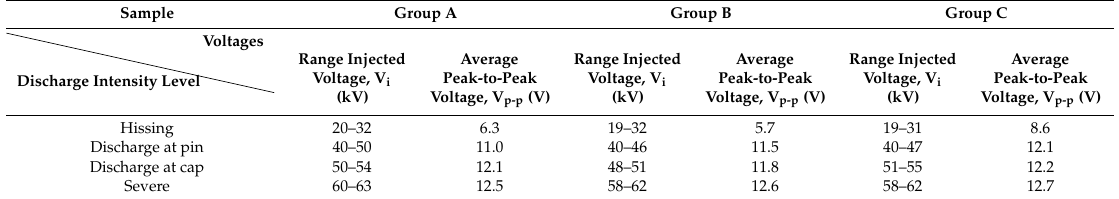
Table 10. Injected voltage and average peak-to-peak voltages of the UV signals for dry insulators conditions with medium contamination level.